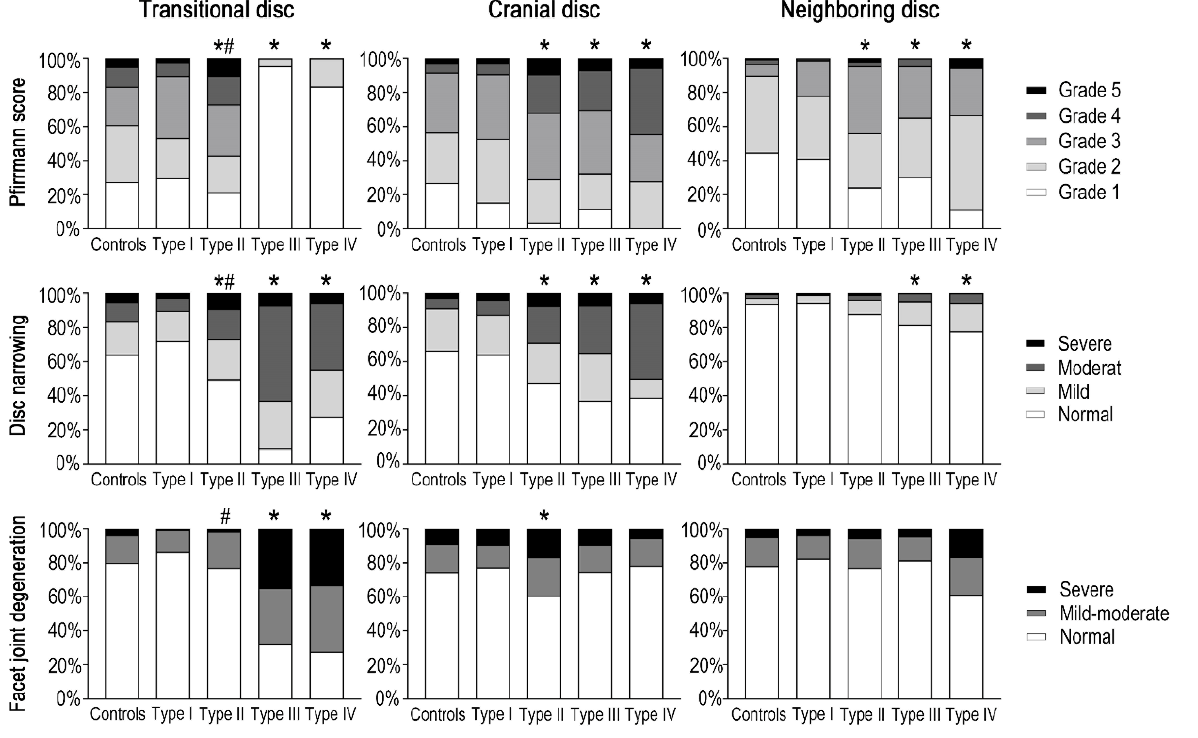
Figure 2. Pfirrmann scores, disc narrowing, facet joint degeneration, ligamentum flavum thickening, and spinal canal narrowing among patients with LSTV type I (N = 182), type II (N = 107), type III (N = 43), type IV (N = 18), and controls (N = 179). *: p < 0.05; measurements of the controls were the references. # : p < 0.05; measurements of type II were the references. Table 1. Degenerative findings on lumbar MRIs for patients with LSTV and controls. Controls (N = 179)